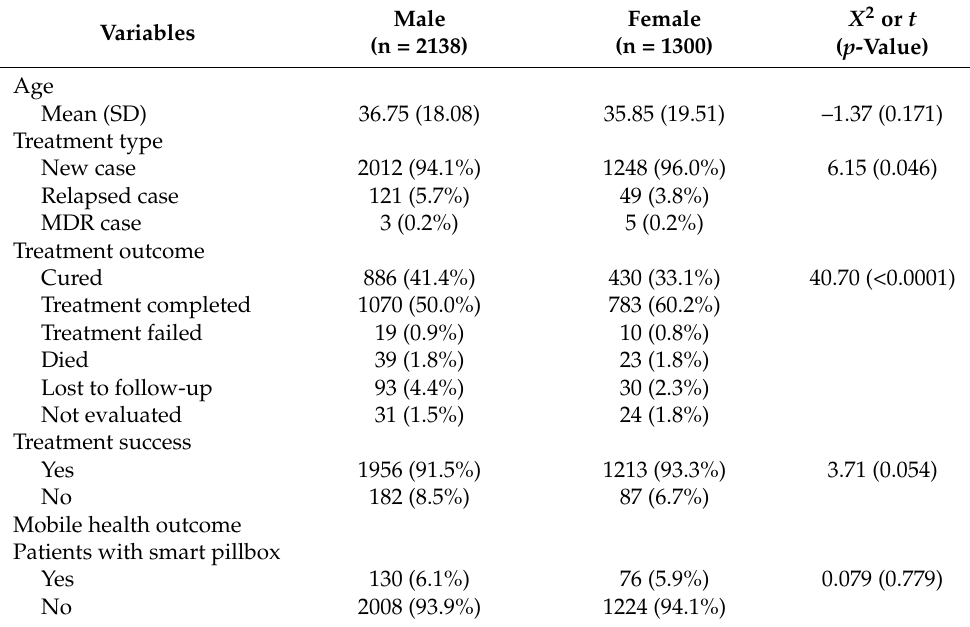
Table 2. Baseline characteristics and treatment outcomes of TB patients by gender